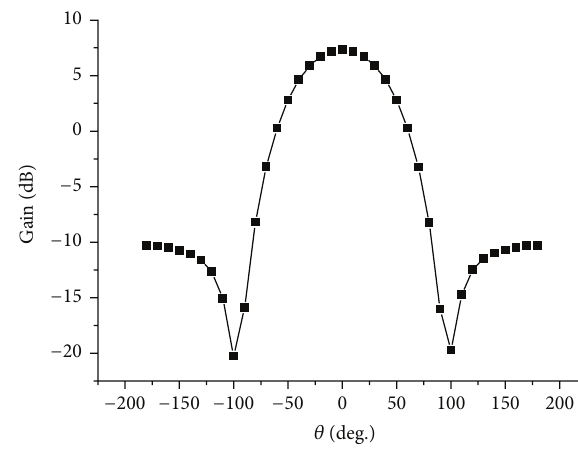
Figure 3: The gain of the antenna with 𝑓 = 32 GHz and ℎ = 0.75𝜆 .